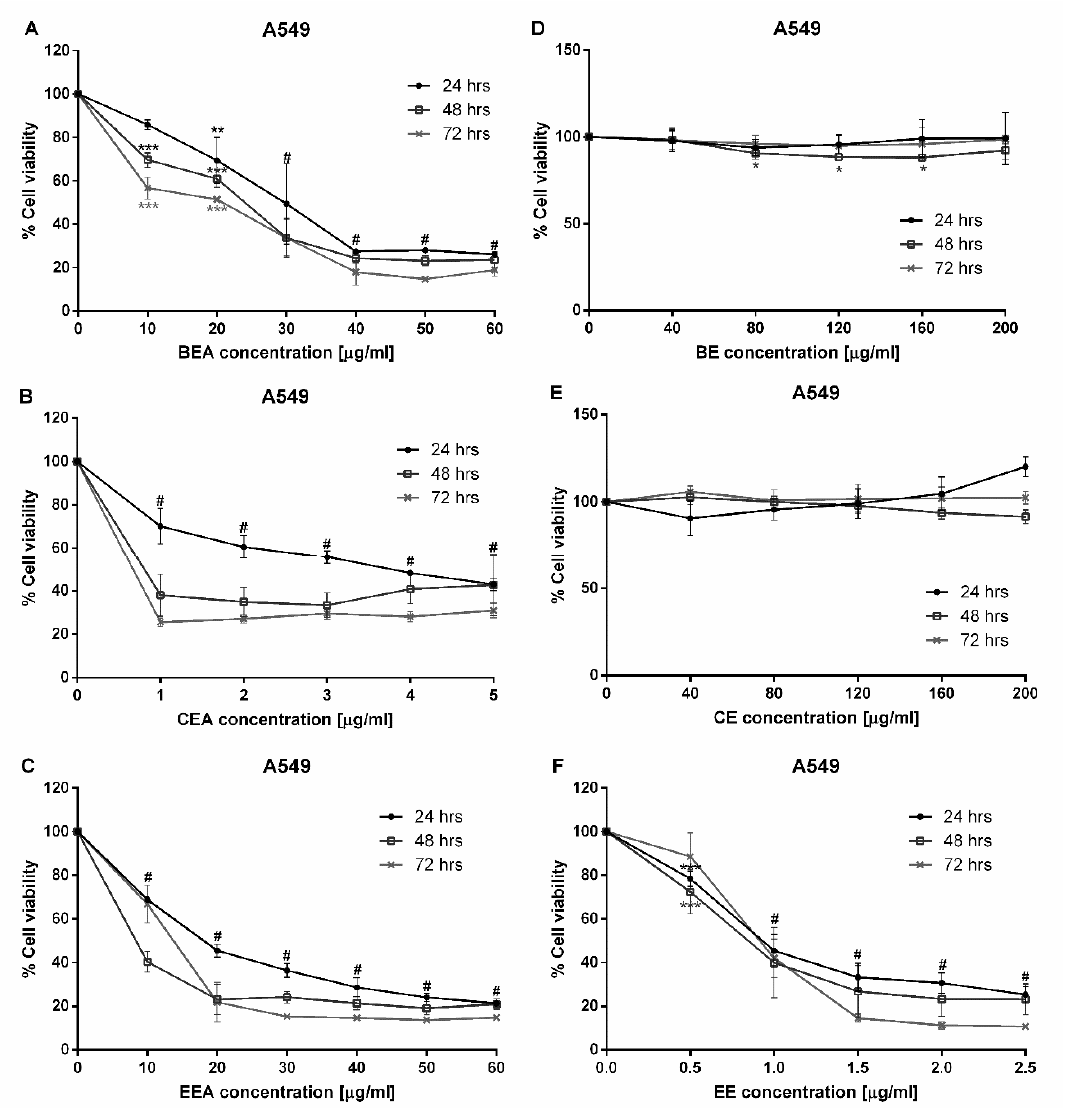
Figure 1. Cytotoxicity of the herbal extracts against the human lung cancer A549 cell line. Percent cell viability of A549 cells is shown on the Y -axis. The cells were determined after treatment with ( A ) BEA, ( B ) CEA, ( C ) EEA, ( D ) BE, ( E ) CE, and ( F ) EE for 24, 48, and 72 h at indicated concentrations as shown on the X -axis. The data are reported as mean ± SD of three independent experiments and was carried out in triplicate, * p < 0.05, ** p < 0.01, *** p < 0.001, and # p < 0.001 for all incubation times compared to the control condition.